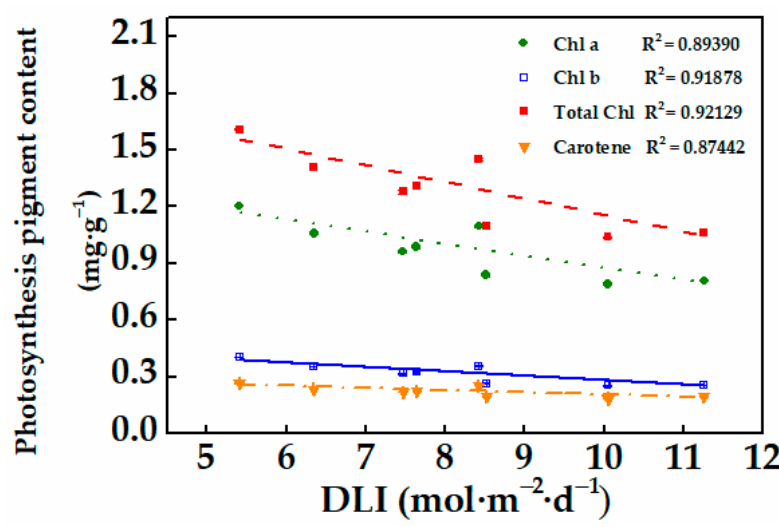
Figure 5. Relationships between DLI and photosynthesis pigment content of cucumber seedlings. Each symbol represents the mean of three repeats in each treatment, and error bars represent SEs of means. Fitting formula shown in supplementary section.